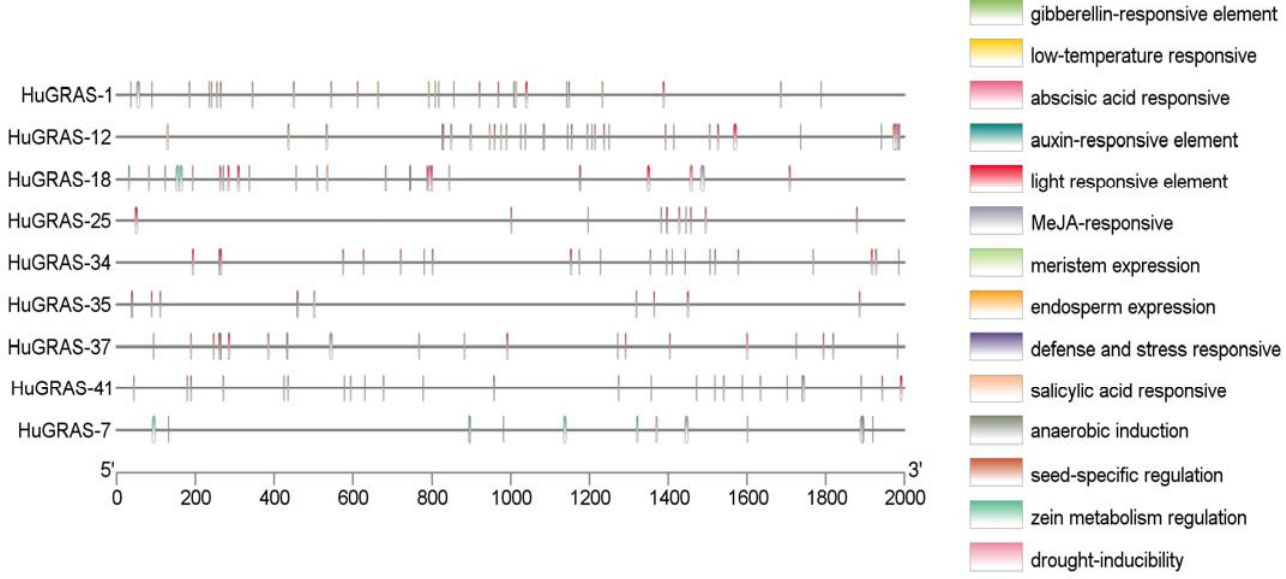
Figure 7. The cis-acting elements of the promoter regions (2000 bp upstream of start codon) of nine HuGRAS genes.